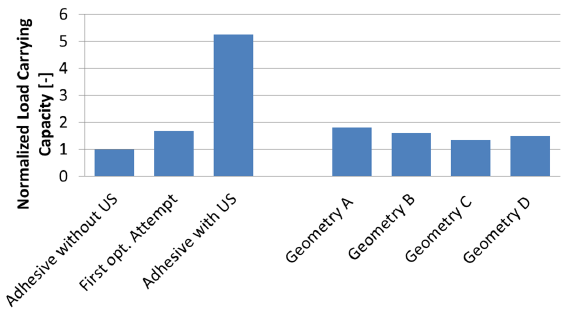
Figure 7. Normalized load-carrying capacity improve- ment